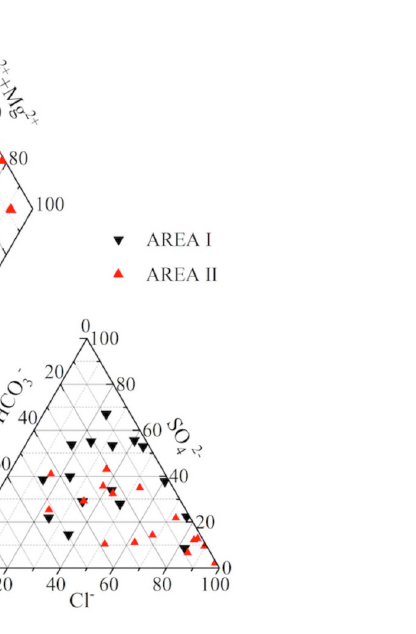
Fig 2. Piper diagram of groundwater points in the study